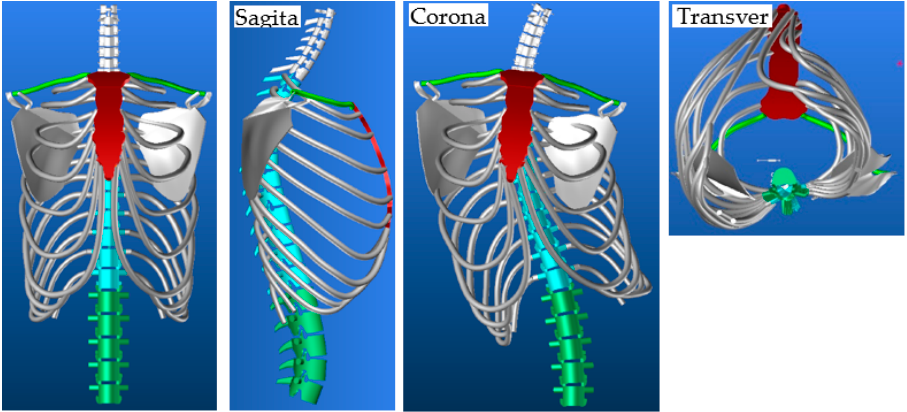
Figure 16. Evolution of the thorax model in sagittal, coronal, and transverse planes.